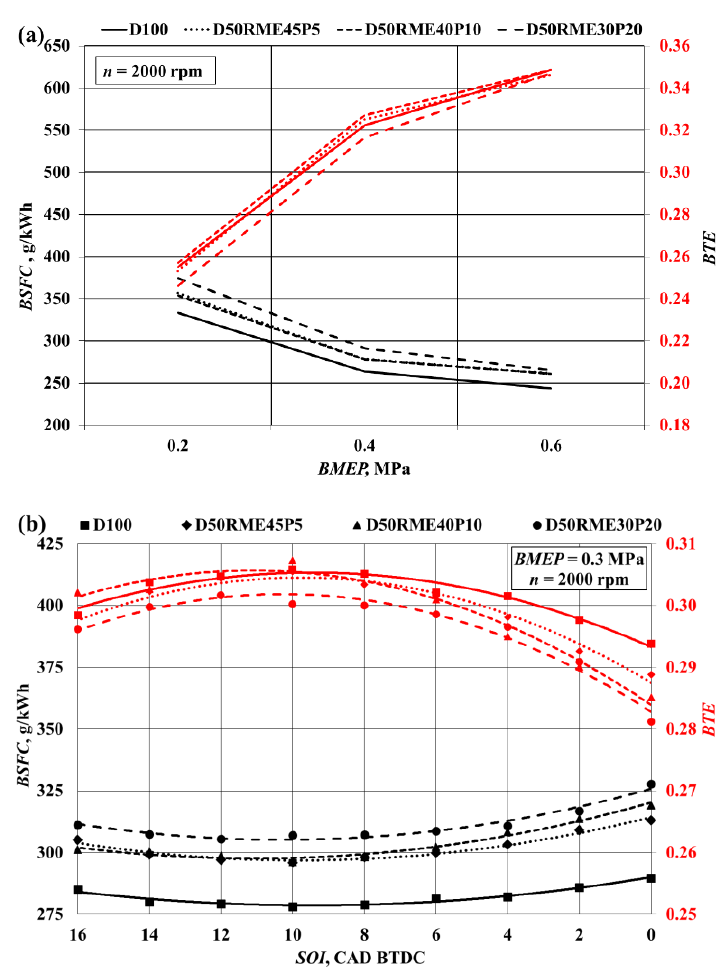
Figure 3. Dependence of Brake Specific Fuel Consumption and Brake Thermal Efficiency on different: ( a ) loads; ( b ) injection timing.